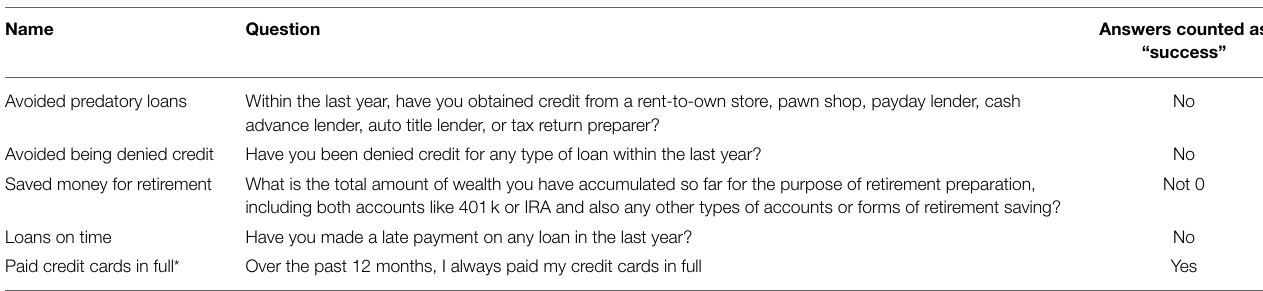
TABLE 6 | Financial outcomes in Study 2.